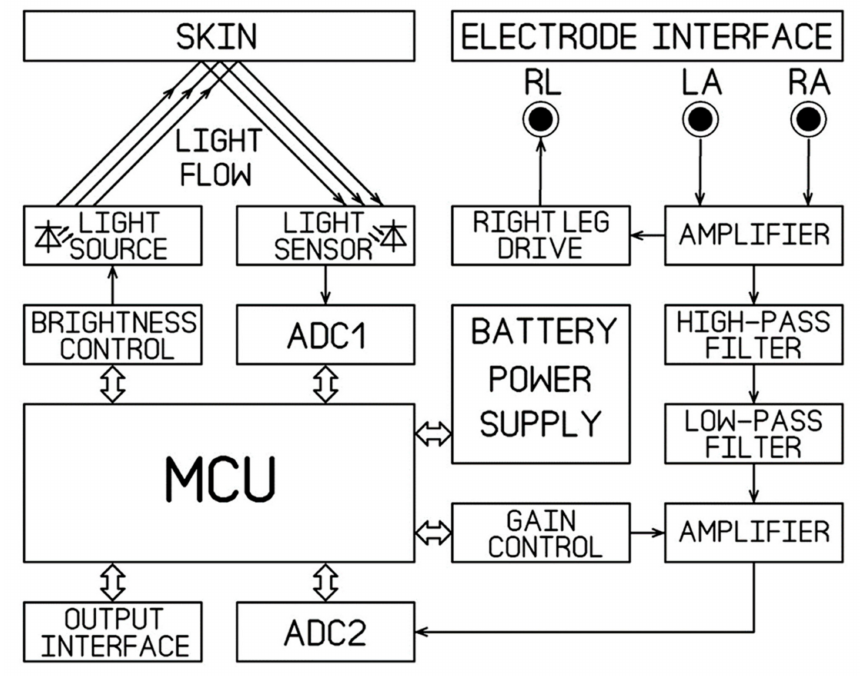
Figure 1. The system block diagram.